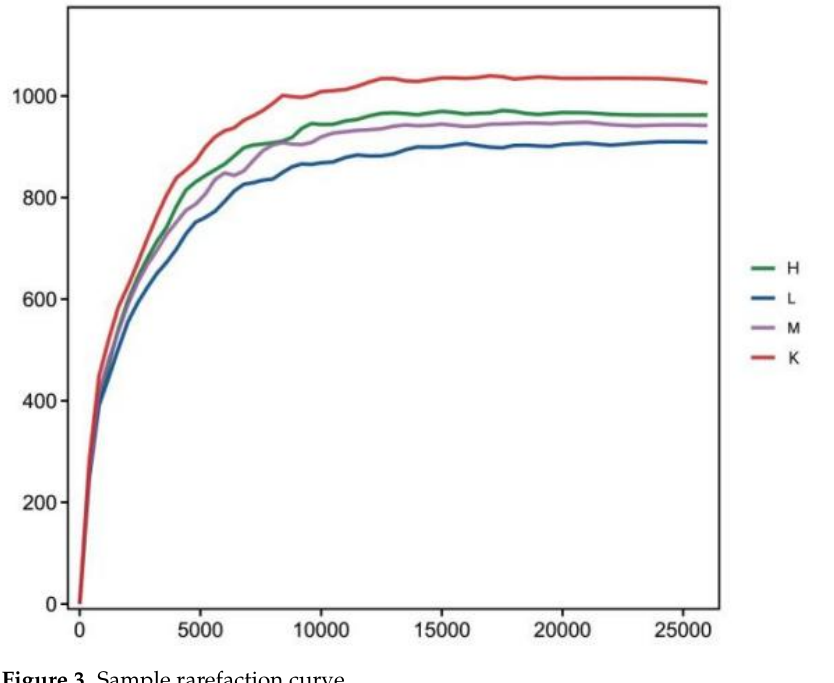
Figure 4. Species Abundance Rank Curve. 3.5. β -Diversity The results from the analysis of differences between the PCoA samples are shown in Figure 5a. The points of color do not overlap or intersect with each other, indicating that the samples are completely separated, which can better describe the characteristics of the mouse intestine. The results indicate that the microbial colonies in the guts of the mice were altered and varied. Among them, the distance between group H and group K is the largest, indicating that the similarity between group H and K is the lowest, i.e., the simi- larity of the microbial community is the lowest and the difference is large. Furthermore, the distance between group L and group K is the smallest, indicating that group L and K have the greatest similarity. The difference is small. From Figure 5b, NMDS can obtain the stress function value streets = 0.014 ≤ 0.01, which indicates that it has excellent represent- ativeness. From Figure 5c, it can be concluded that R = 0.633 indicates a significant differ- ence between groups, and p = 0.001 < 0.05 is significant. According to the results of the ANOSIM analysis, R = 0.985 indicates a significant difference between groups, and p = 0.001 < 0.01 is extremely significant.